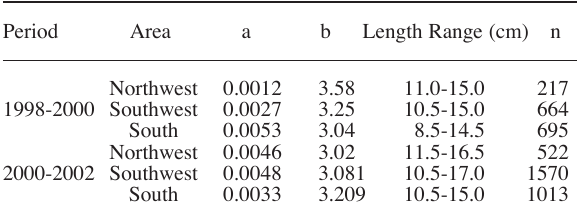
Table 5.- Summary information of the fitted length-weight relation- ships (parameters a and b) and the respective length range for each geographical area prior and after October 2000.